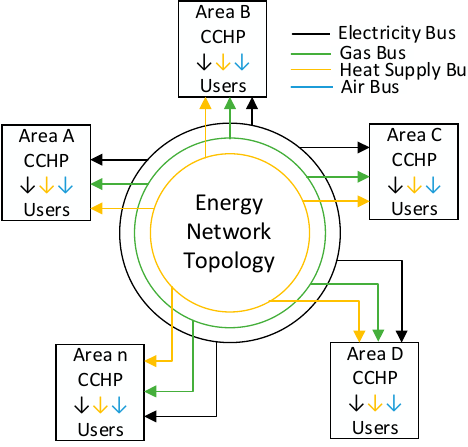
Figure 2. Diagram of the integrated energy micro-grid (IEMG).